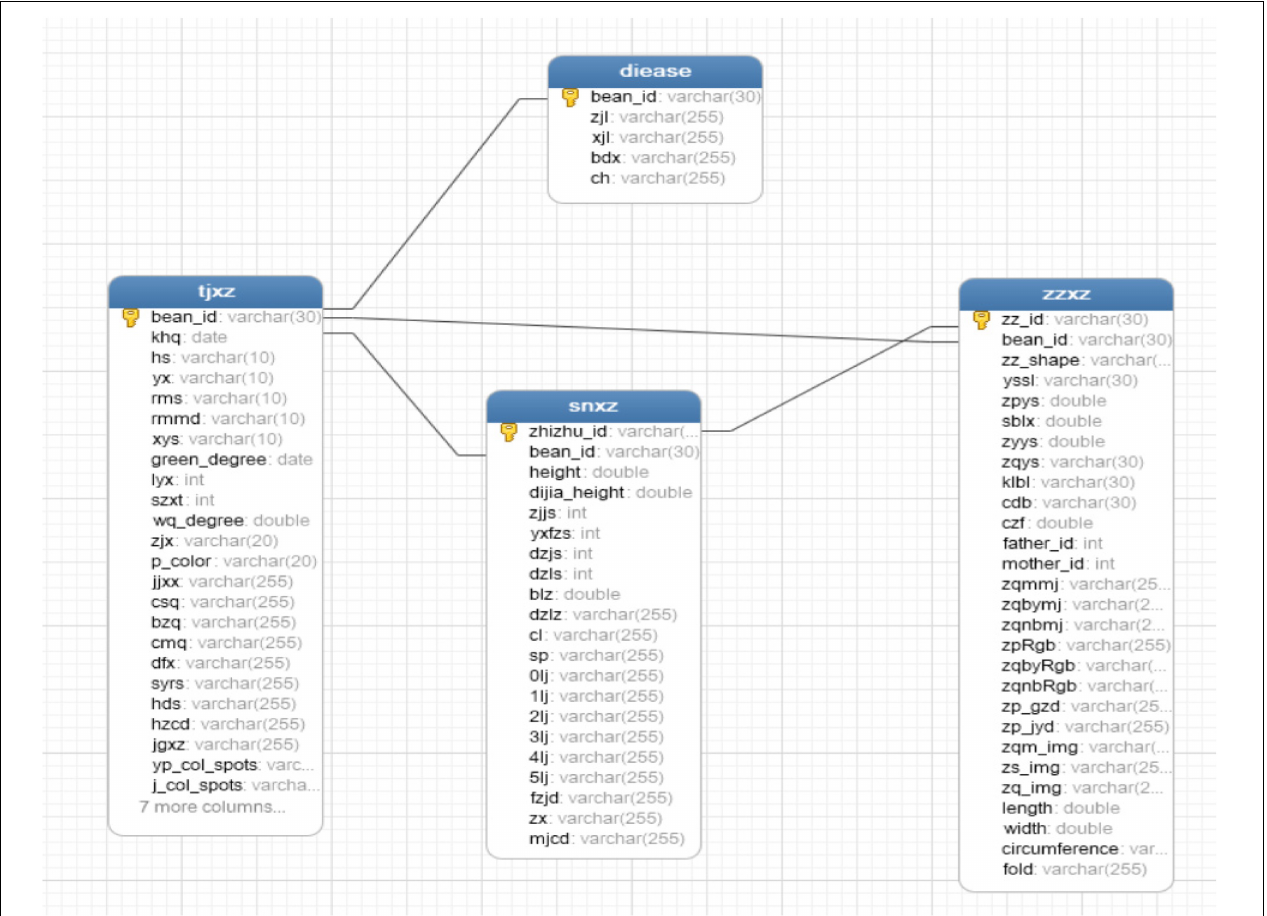
FIGURE 14 | Extended ER